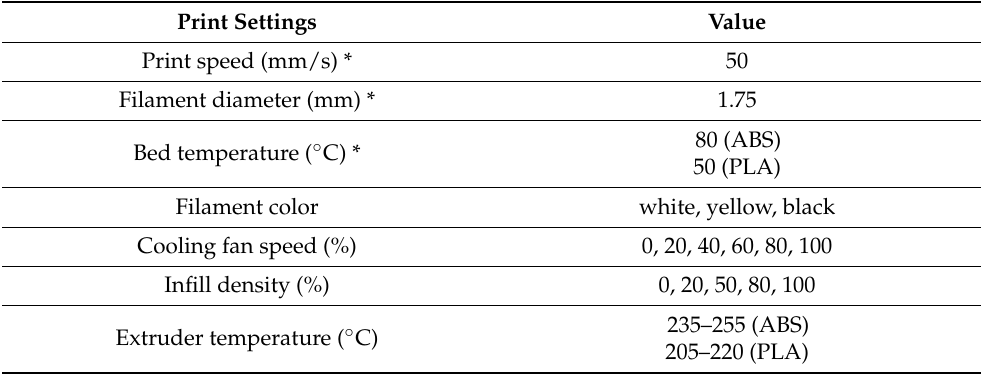
Table 1. Print settings used in this